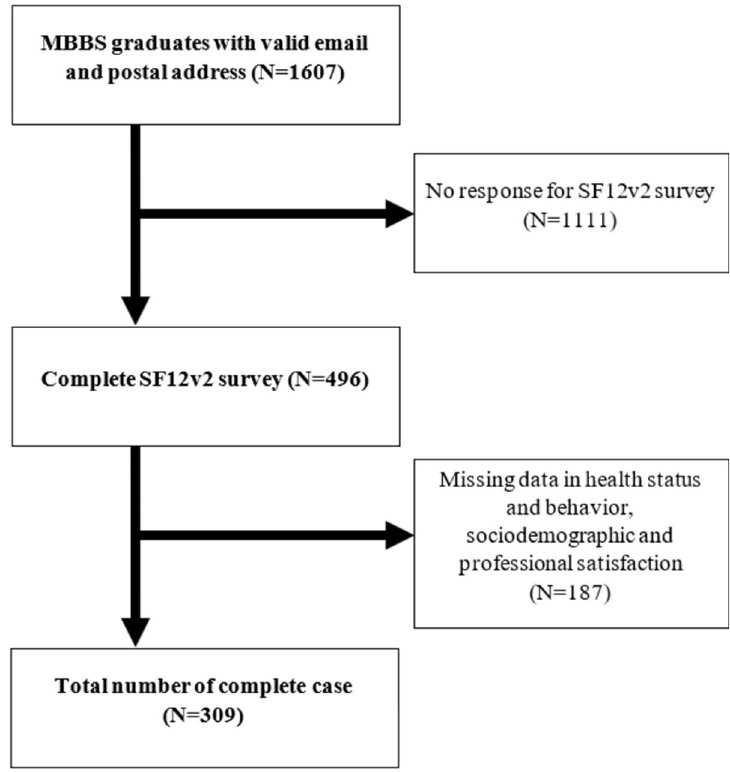
Fig 1. Flow chart showing the sampling and response rates. MBBS, Bachelor of Medicine, and Bachelor of Surgery. SF12v2, The Short Form 12-Item Health Survey version 2.